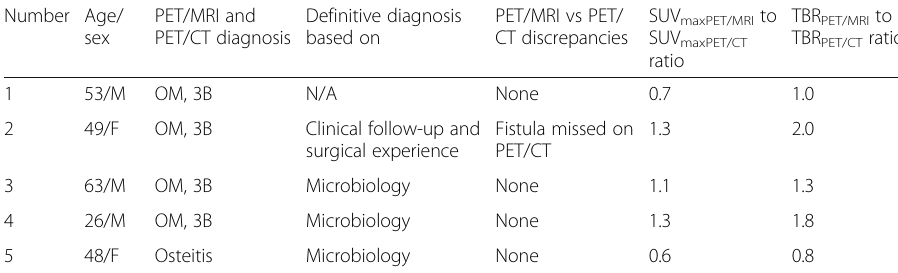
Table 6 Pooled results Number Age/ PET/MRI and sex PET/CT diagnosis